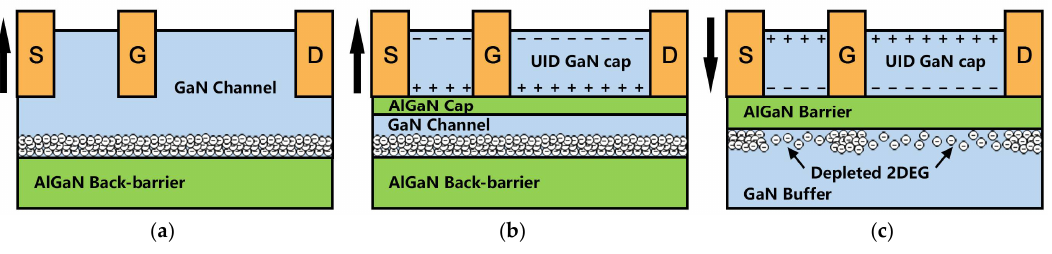
Figure 8. Schematic diagrams of on-state device operation for deep recess GaN HEMT with different structures. ( a ) N-polar; ( b ) N-polar with AlGaN cap; ( c ) Ga-polar.